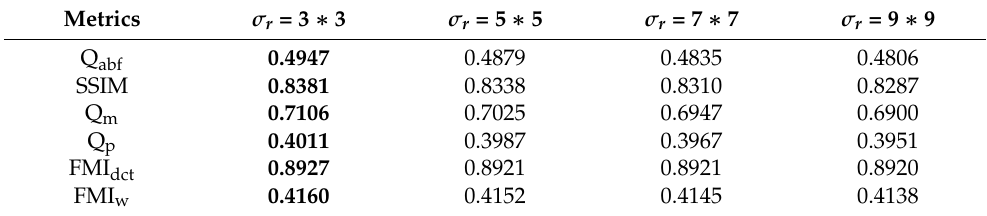
Table 5. Averages of the six metrics for different σ r on ten pairs of source images from two public datasets. Numbers in bold font represent the best